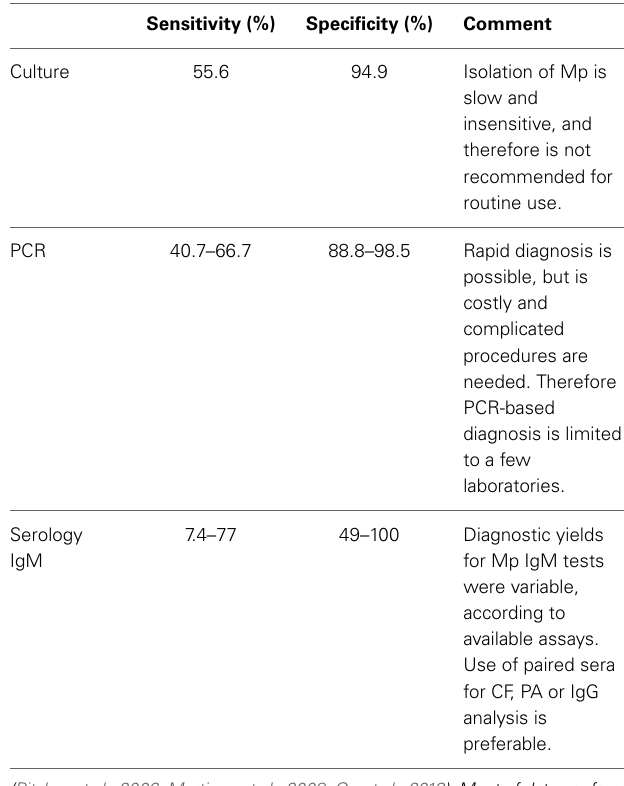
Table 3 | Comparison of diagnostic